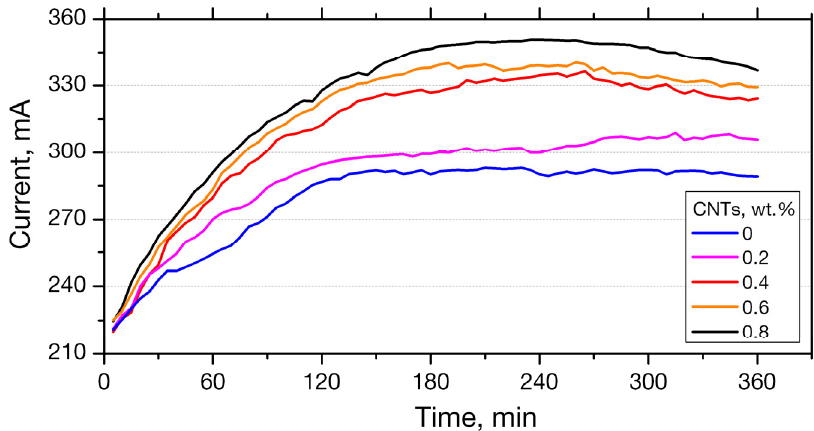
Figure 5. Current passing through nano-modified mortars with different amount of carbon nanotubes